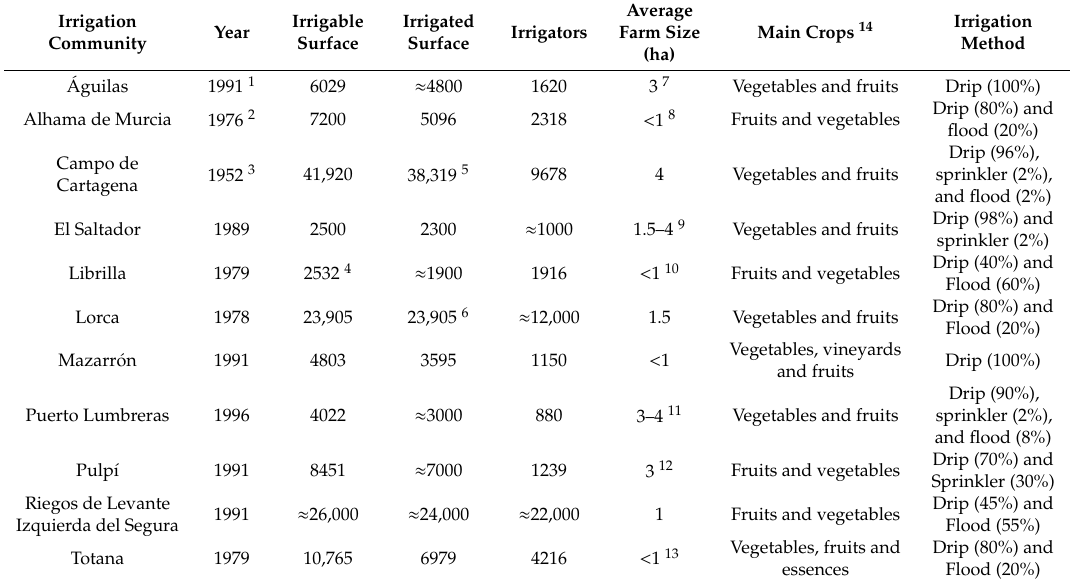
Table 1. Irrigation communities’ basic